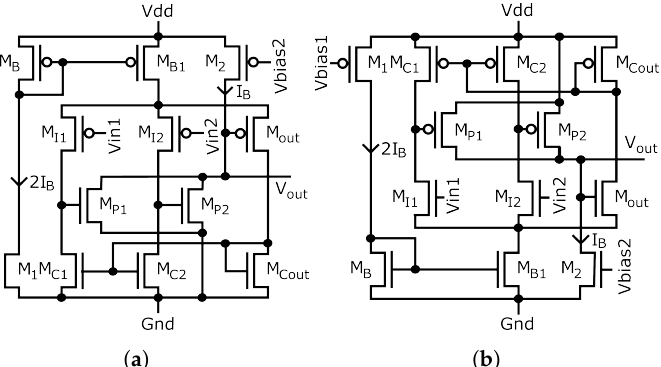
Figure 6. Circuit diagram to determine the minimum and maximum values between two voltages: ( a ) Minimum circuit diagram. ( b ) Maximum circuit